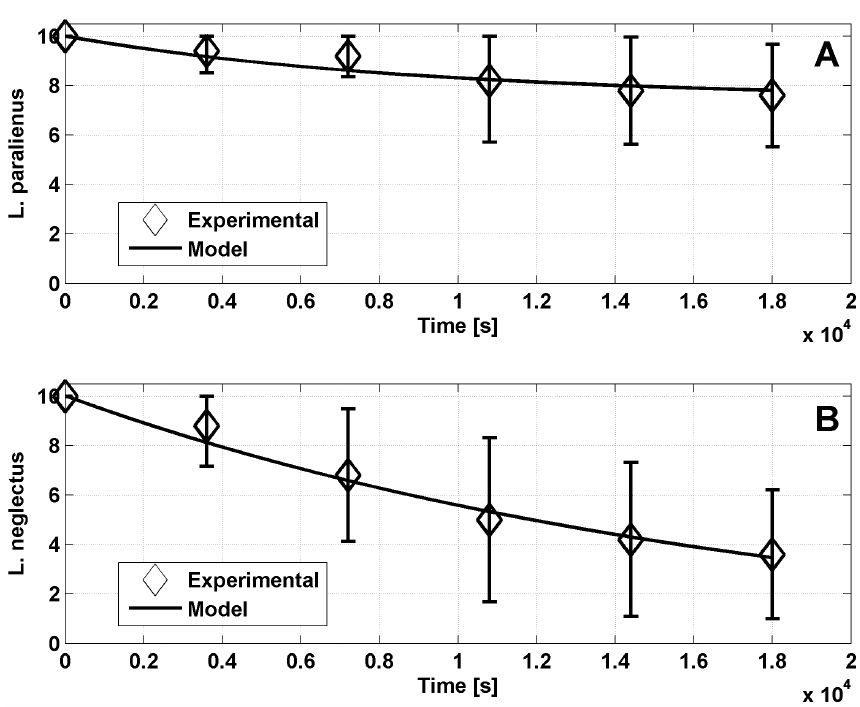
Figure 7. Mortality fitting. Calibration of the model with the 5-hour mortality experiments (black-line). The average of experimental data is indicated by diamonds: (A) species A ( L : neglectus ), (B) species B ( L : paralienus ).